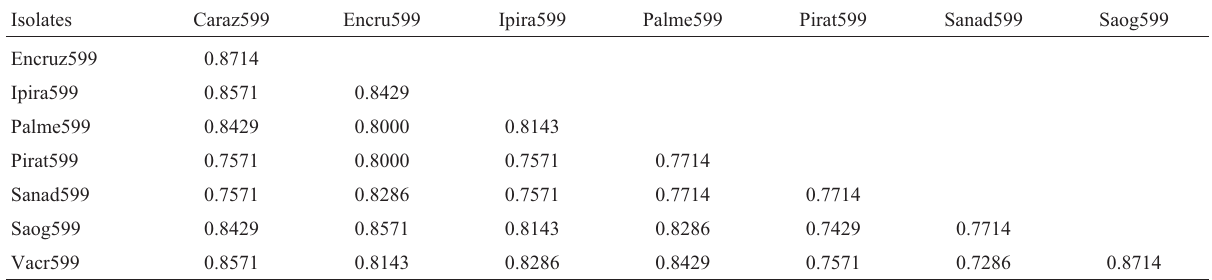
TableIII - Drechslerateres similaritymatrixcoefficientsbasedonbothcolonymorphologyandrandomamplifiedpolymorphicDNA(RAPD)analysis. Isolates